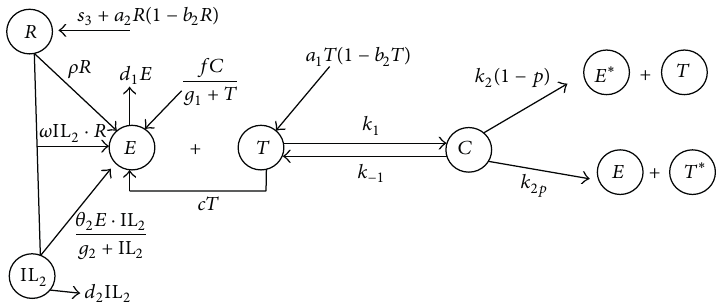
Figure 1: Schematic diagram of the local kinetic cell interactions